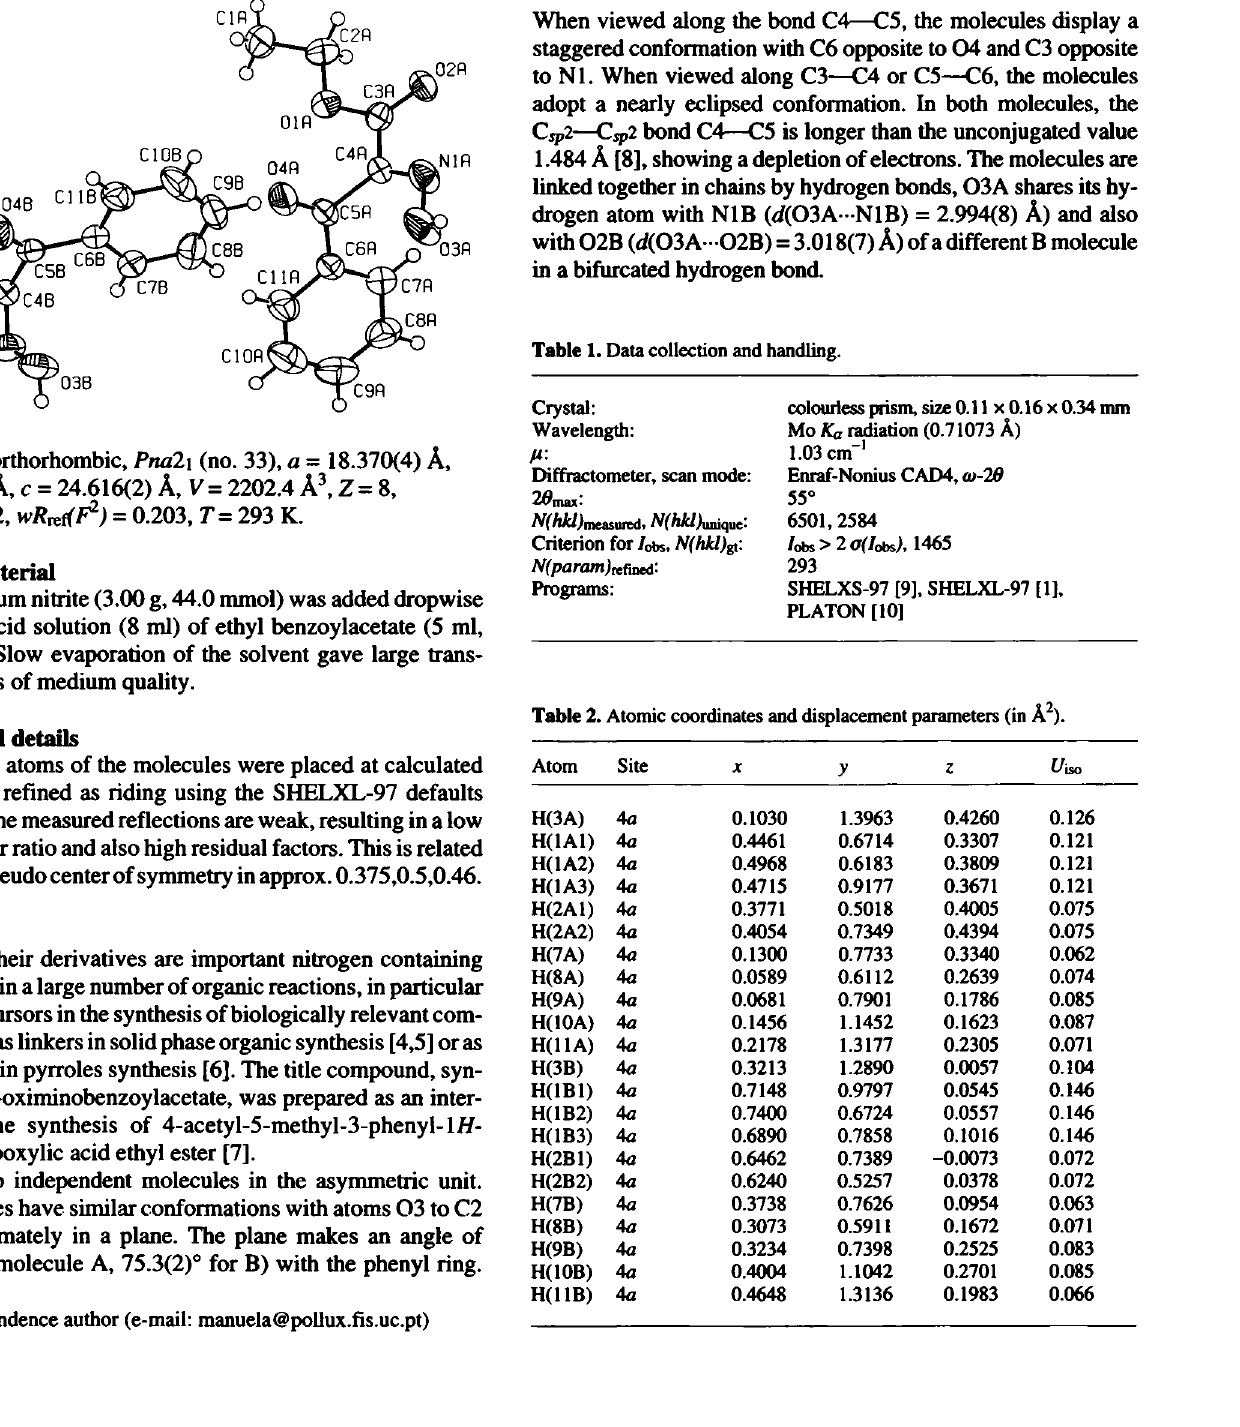
Table 1. Data collection and handling.